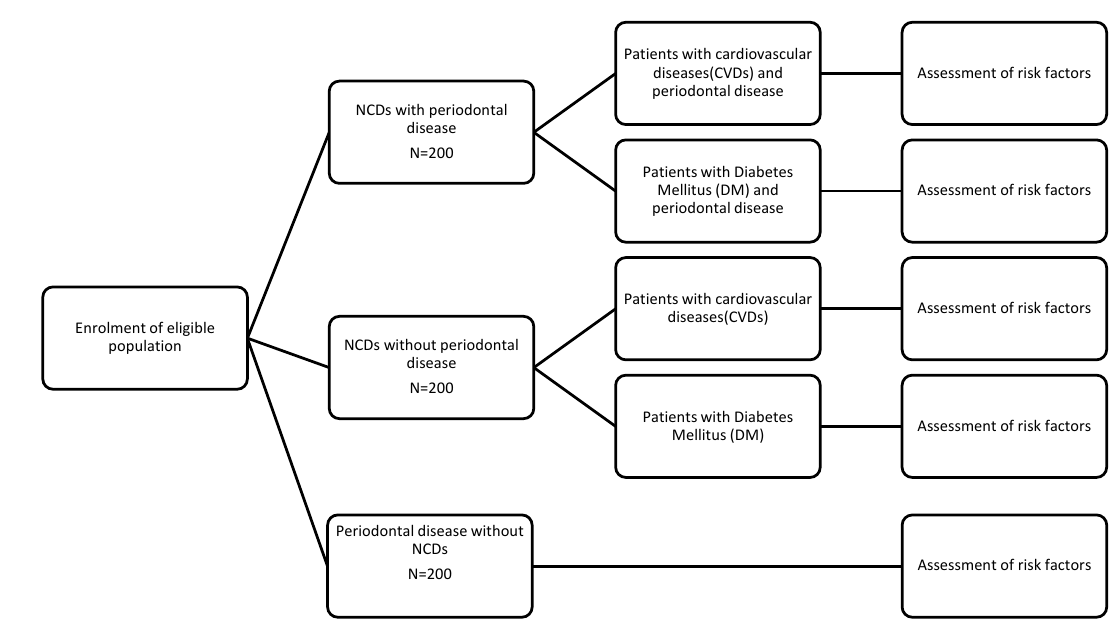
Figure 3. Split up of sample size.